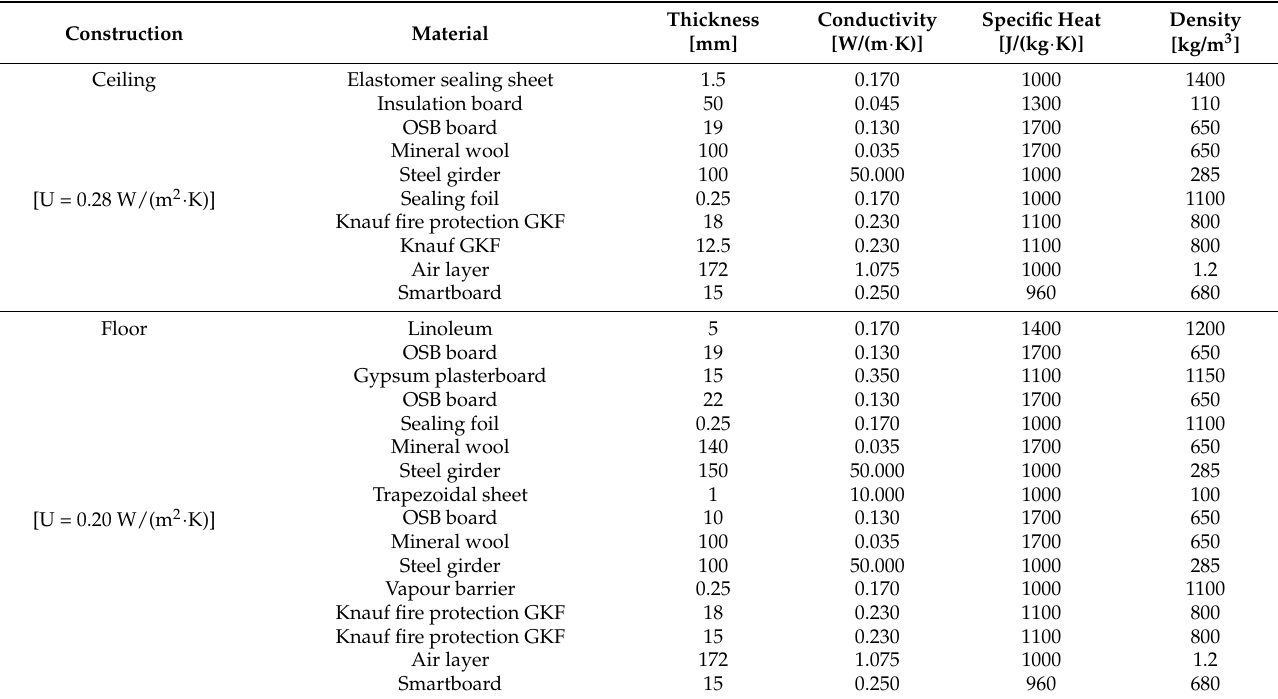
Table A2. Thermal properties of construction elements: classroom. Values obtained from Ubakus online calculator